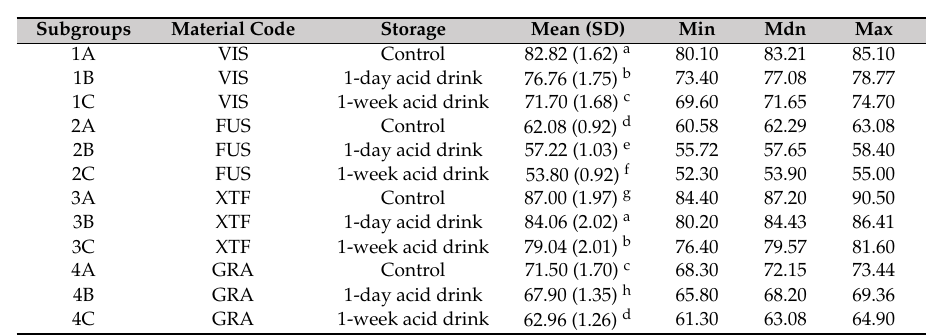
Table 5. Descriptive statistics of VHN for each tested material, considering two di ff erent acid storages compared to a group